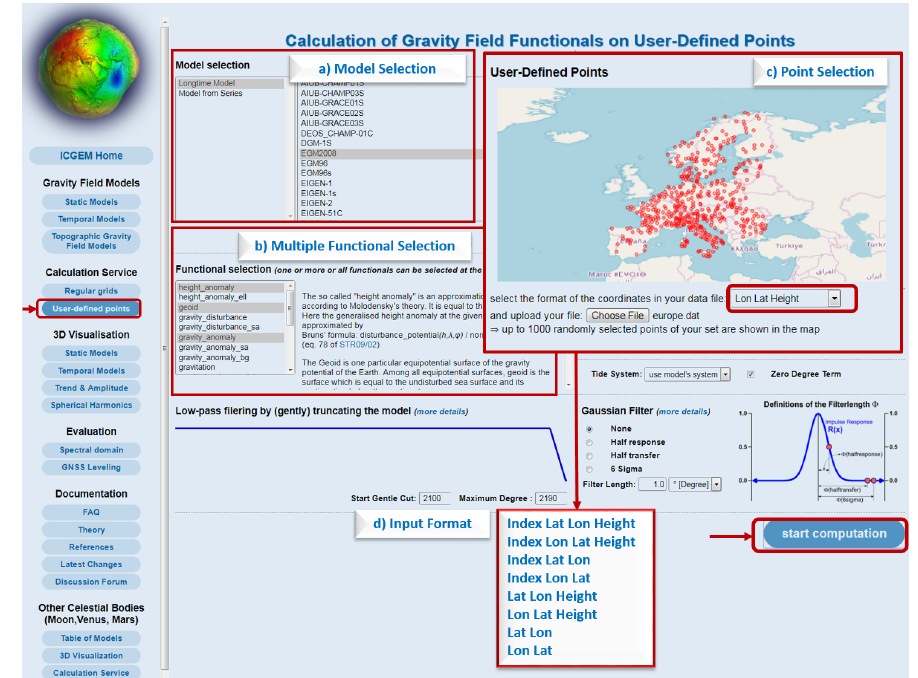
Figure 12. Snapshot of the point value calculation service on ICGEM, (a) the model selection, (b) functional selection (choosing multiple functionals or all is possible), (c) input file selection and mapping of the location of user-defined points, and (d) input file format as a TXT file. The example shows the GNSS/levelling benchmark points in Europe that are also used in the ICGEM static model